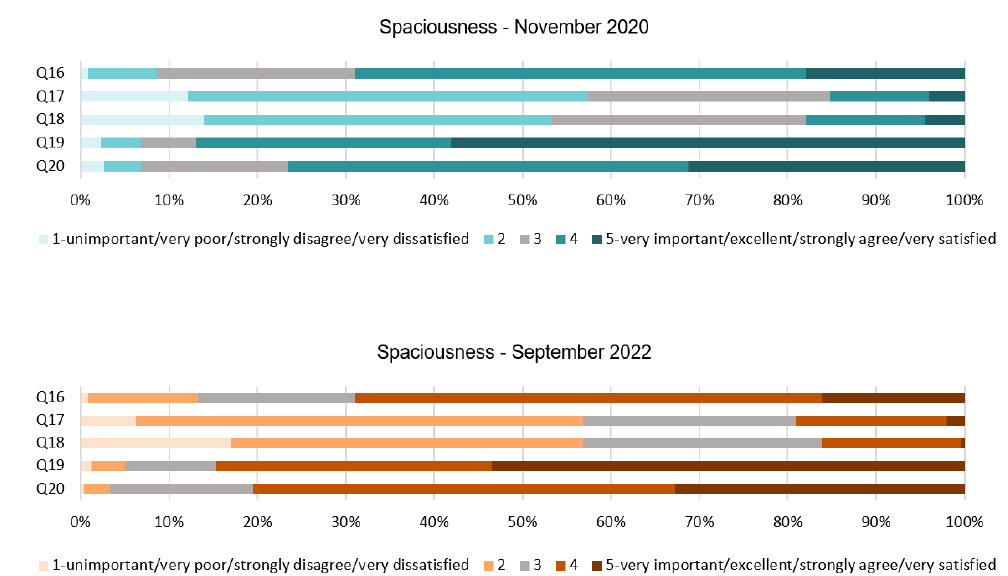
Figure 8. Spaciousness dimension chart.